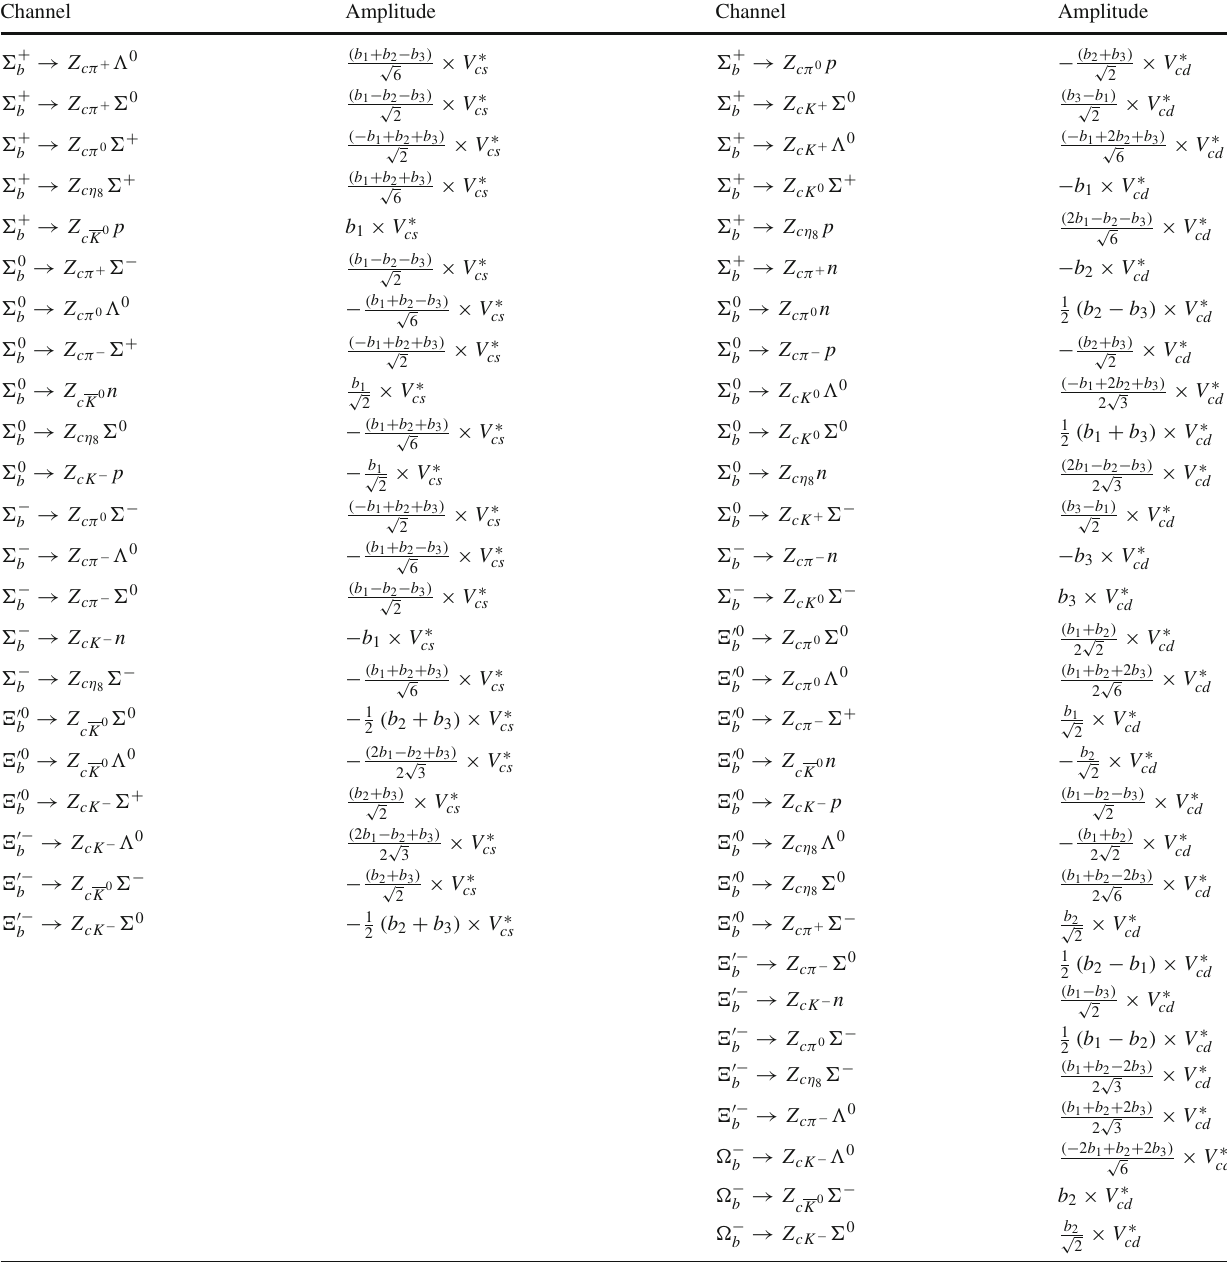
Table 2 Amplitudes for b-baryon (sextet) decays into a tetraquark and a light baryon Channel Amplitude Channel